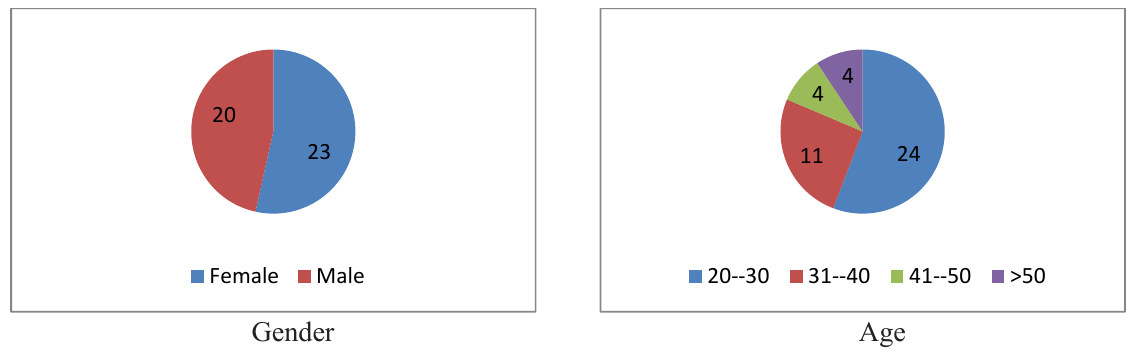
Fig. 1. Personal characteristics of the